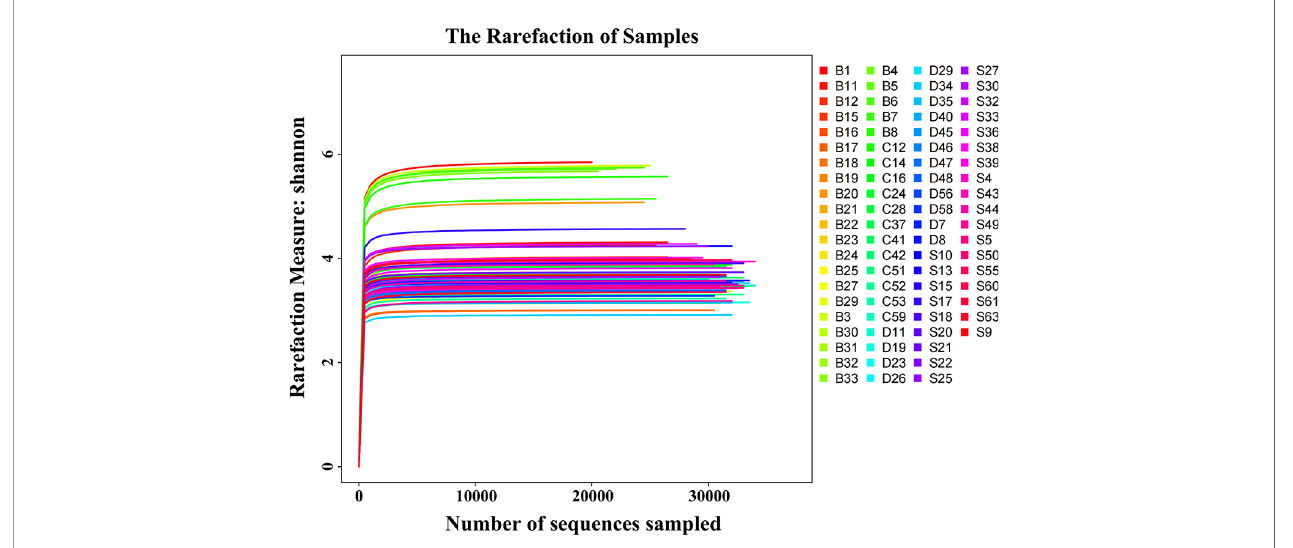
FIGURE 1 | Shannon rarefaction curves of all SPM samples. The horizontal coordinate is the number of sequences sampled. The vertical coordinate is the corresponding Shannon index of the sample. In the case of very few sampled sequences, the Shannon index has reached a plateau. S, CP children with severe or extremely severe caries; B, non-CP children with severe or extremely severe caries; C, CP children with mild-to-moderate caries; D, CP children without